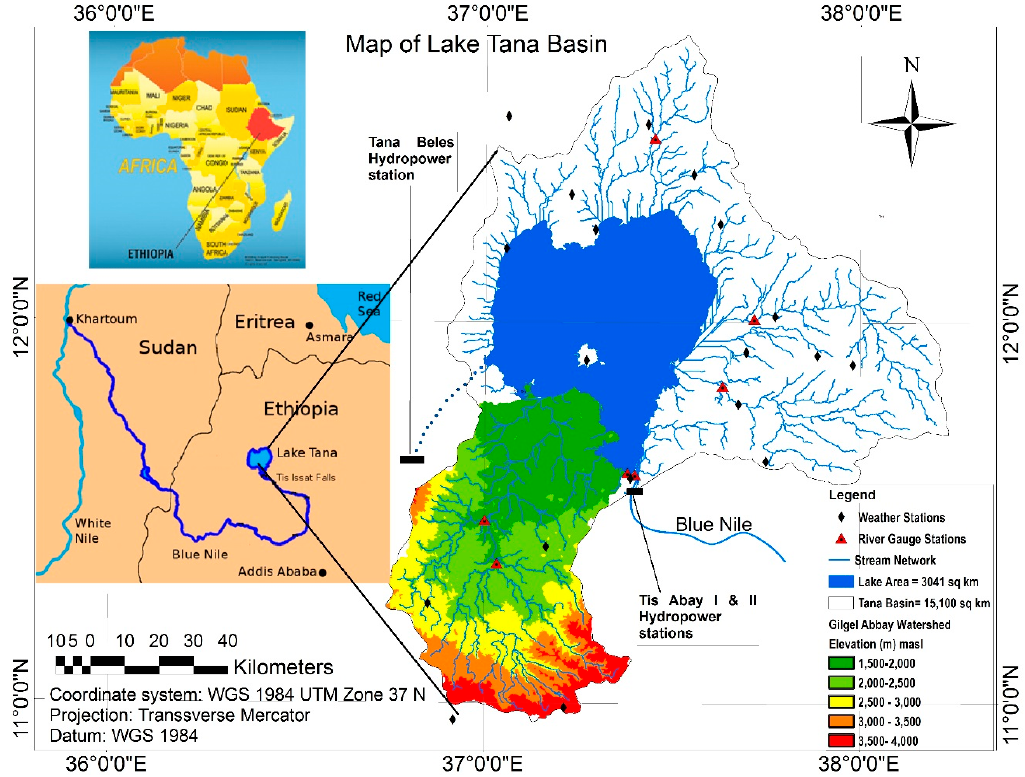
Figure 1. Location of study area, streamflow and metrological stations of Lake Tana Basin.